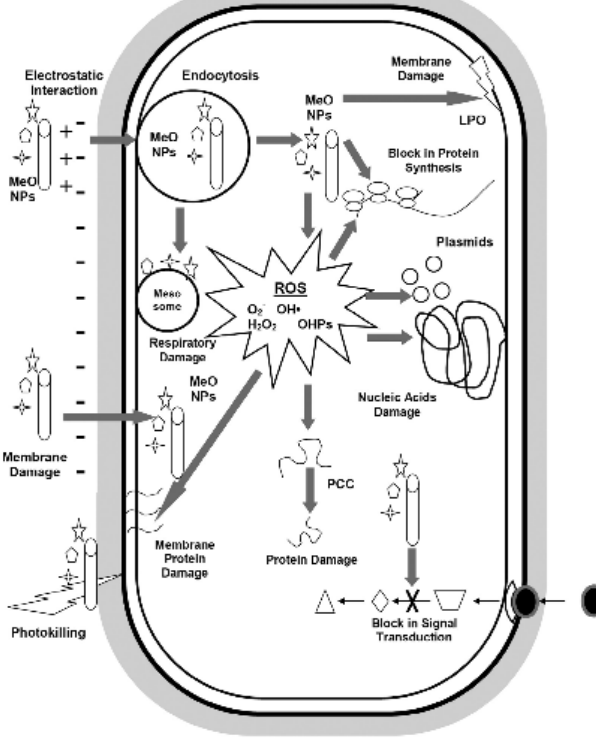
Figure 5. Graphic representation showing the antimicrobial mechanisms of metal oxide nanoparticles. Reproduced from Raghunath and Perumal [44] with permission from Elsevier.